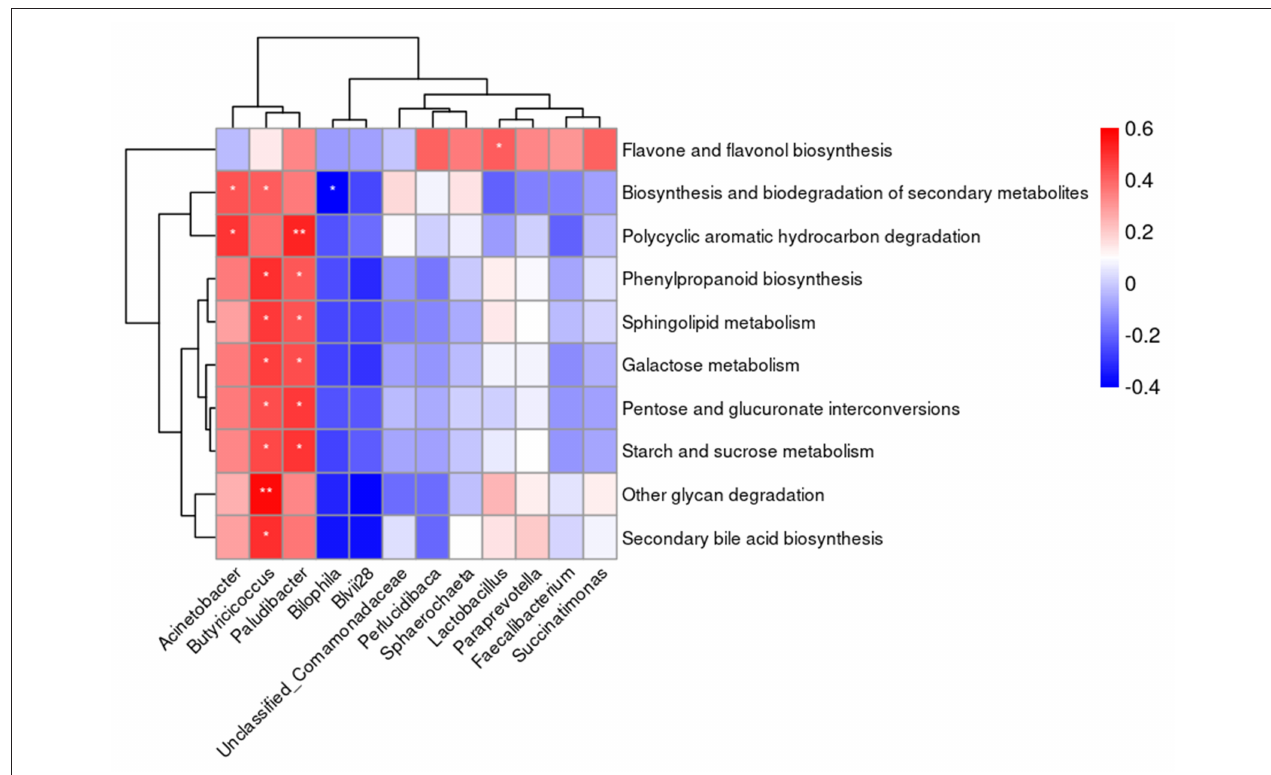
FIGURE 6 | The correlation heatmap between the abundance of microbiota at genus level in the cecal content and the predicted metabolic functions. * P < 0.05, ** P <